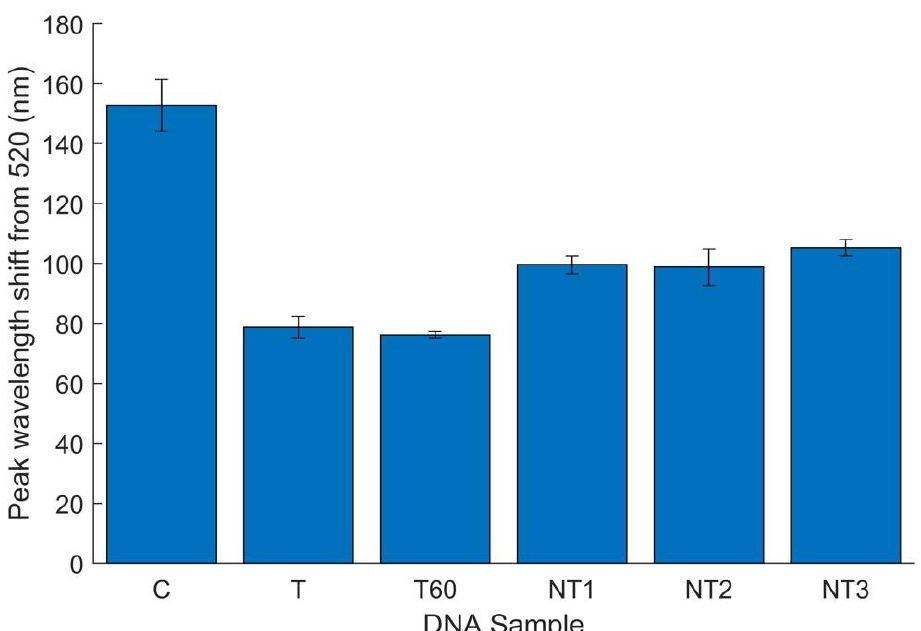
Figure 8. E. coli O157 specificity results in flour, analyzed by peak wavelength shift from 520 nm. Six replicates total with DNA concentrations of 60 ± 5 ng/µL unless otherwise noted. Error bars represent 95% confidence intervals. C, water; T, E. coli O157 at 83.4 ng/µL; T60, E. coli O157 at 60 ng/µL; NT1, E. coli C-3000; NT2, Listeria monocytogenes ; NT3, flour without artificial inoculation.